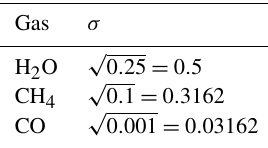
Table 6. Prior uncertainties σ (standard deviations) for the scaling factors applied to the prior profiles for H 2 O, CH 4 and